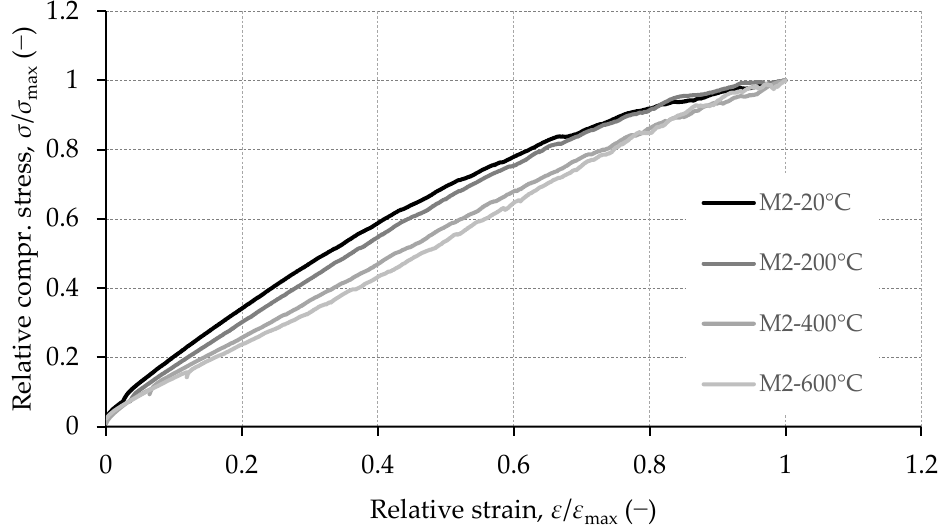
Figure 16. Relative compressive stress vs. relative strain for mixture M2. Nonlinear regression analysis using least squares method was applied to evaluate how well the model from Equation (1) represents experimentally determined stress–strain curves. Multiplying Equation (1) with peak stress ( σ max ) yields the stress–strain relationship in absolute units. The differences between the values predicted by the model and the observed values were evaluated by the root mean square error ( S ). The range of S for samples from all mixes kept at 20 ◦ C was 1.8–3.9 MPa. For specimens exposed 200 ◦ C, 400 ◦ C and 600 ◦ C, the range of S was 0.9–1.9 MPa, 0.2–1.3 MPa and 0.2–1.2 MPa, respectively. As an example, a comparison between model and experimental values for specimens from mix M2 is presented in Figure